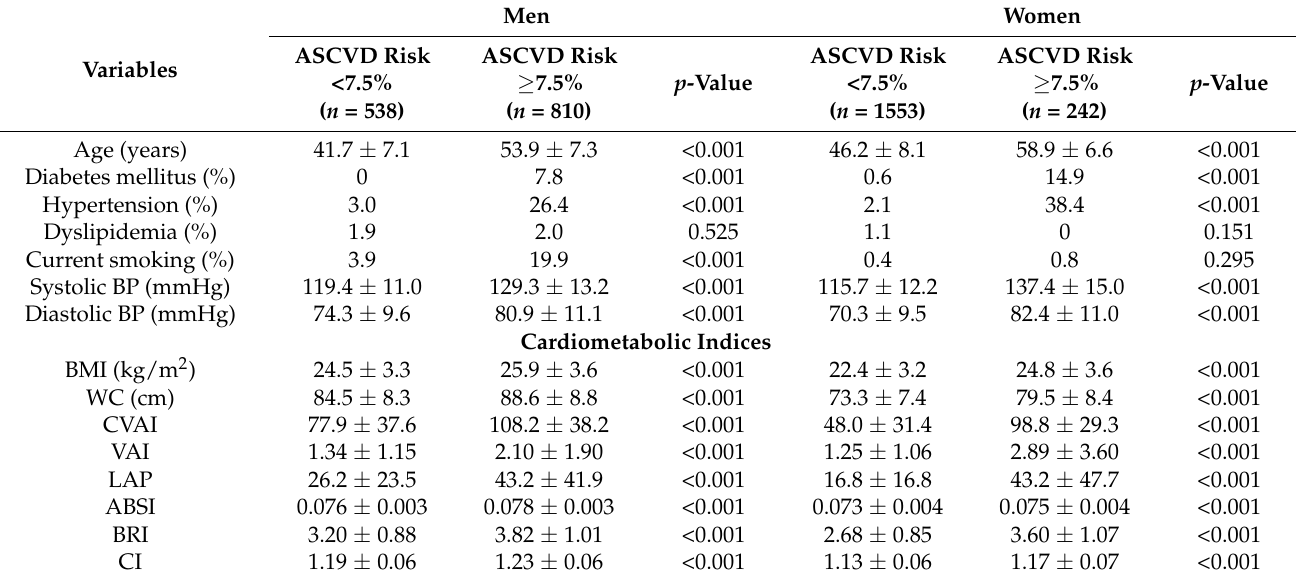
Table 1. Demographic information of study participants stratified by 10-year atherosclerotic cardiovascular disease (ASCVD) risk <7.5% and ≥